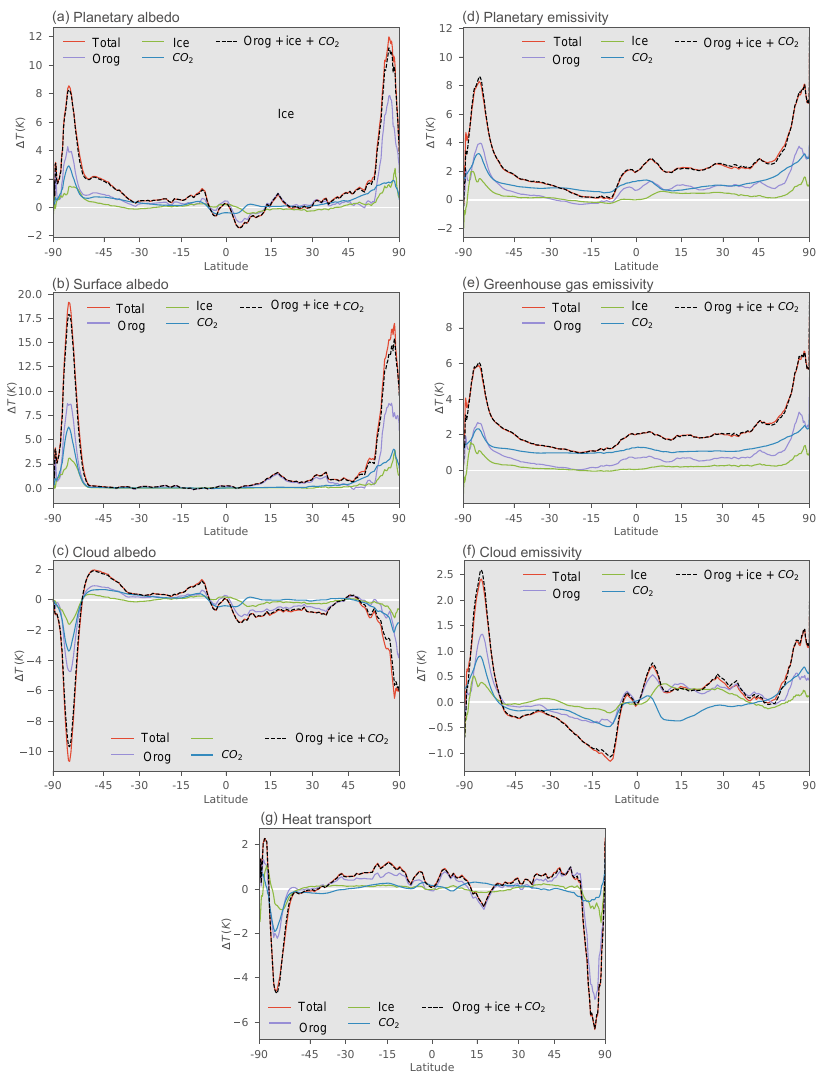
Figure 10. Factorization of the PI to mid-Pliocene change in zonal-mean temperature (red curve) due to change in (a) planetary albedo, (b) clear-sky or surface albedo, (c) cloud albedo, (d) planetary emissivity, (e) clear-sky emissivity or emissivity change due to change in greenhouse gas concentrations including water vapor, (f) cloud emissivity, and (g) meridional heat transport into contributions arising from changes made to the following boundary conditions: orography (purple), ice sheets (green), and atmospheric p CO 2 (blue). The abscissa is linear in the sine of